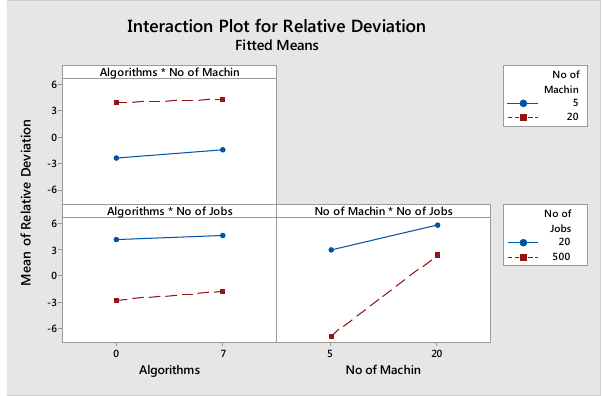
Fig. 8. Interaction Plot for Relative Deviation